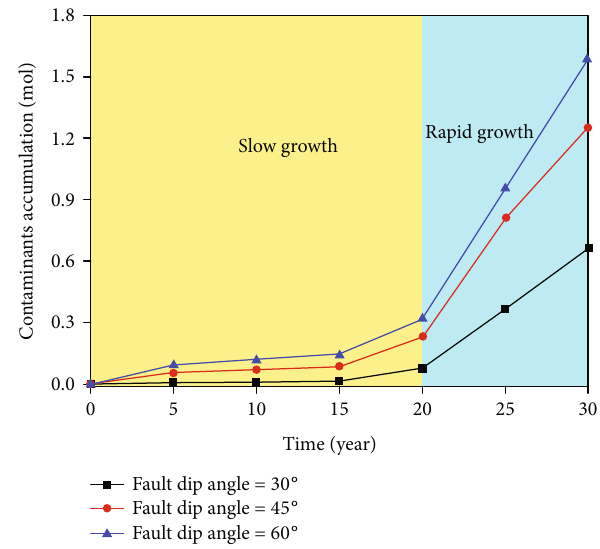
Figure 15: The contaminant accumulation along the line of CD under di ff erent fault dip angles.